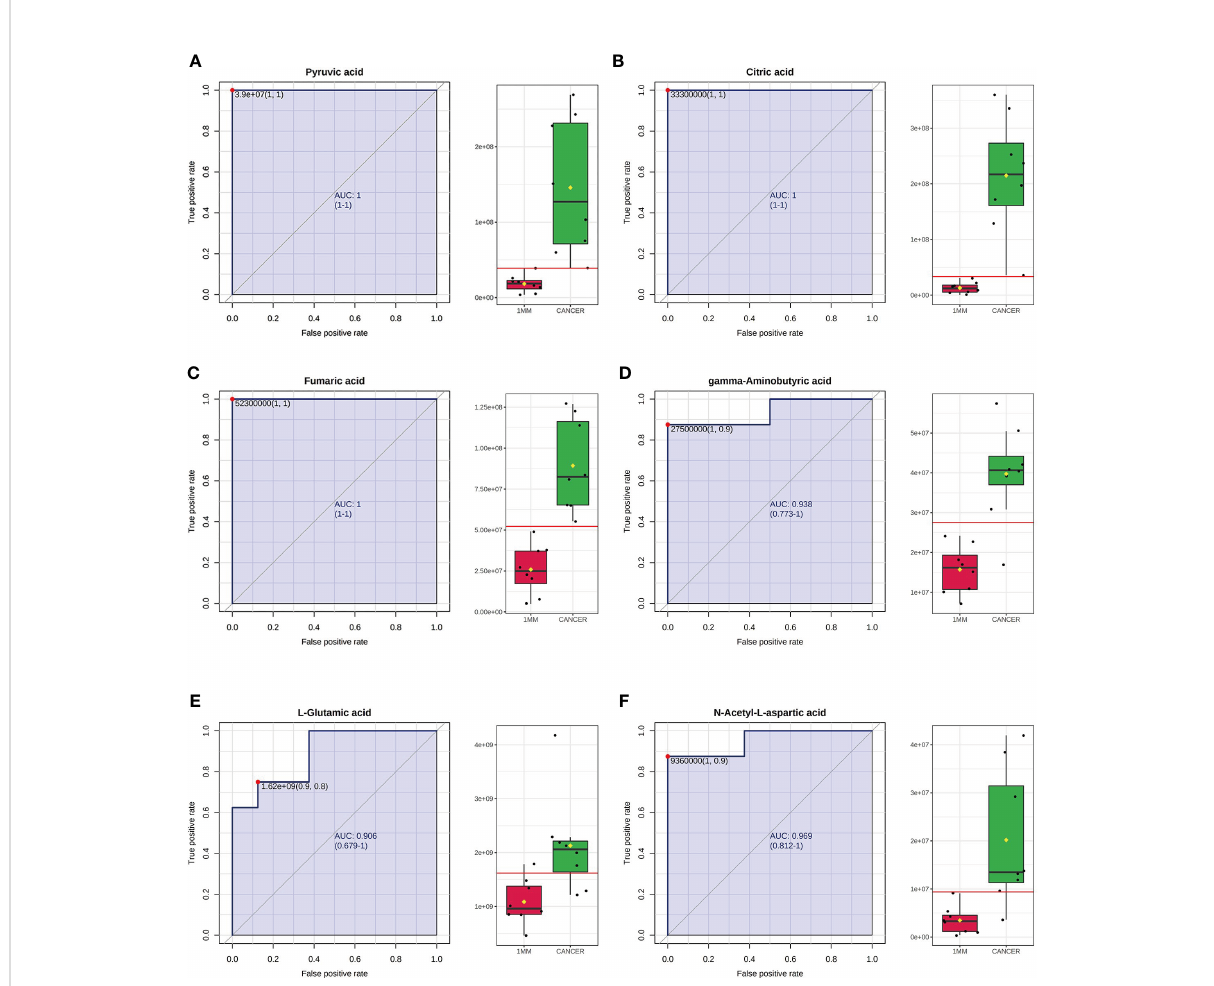
FIGURE 8 Receiver operating characteristic (ROC) curves using the levels of pyruvic acid (A) , citric acid (B) , fumaric acid (C) , gamma-aminobutyric acid (D) , L-glutamic acid (E) and N-acetyl-L-aspartic acid (F) . The AUCs obtained using the levels of pyruvic acid, citric acid, fumaric acid, gamma- aminobutyric acid, L-glutamic acid and N-acetyl-L-aspartic acid were 1 (95% CI=1-1), 1 (95% CI=1-1), 1 (95% CI=1-1), 0.938 (95% CI=0.773-1), 0.906 (95% CI=0.679-1) and 0.969 (95% CI=0.812-1), respectively. The box plots show the median, quartiles, and whole range of peak areas of the levels of these